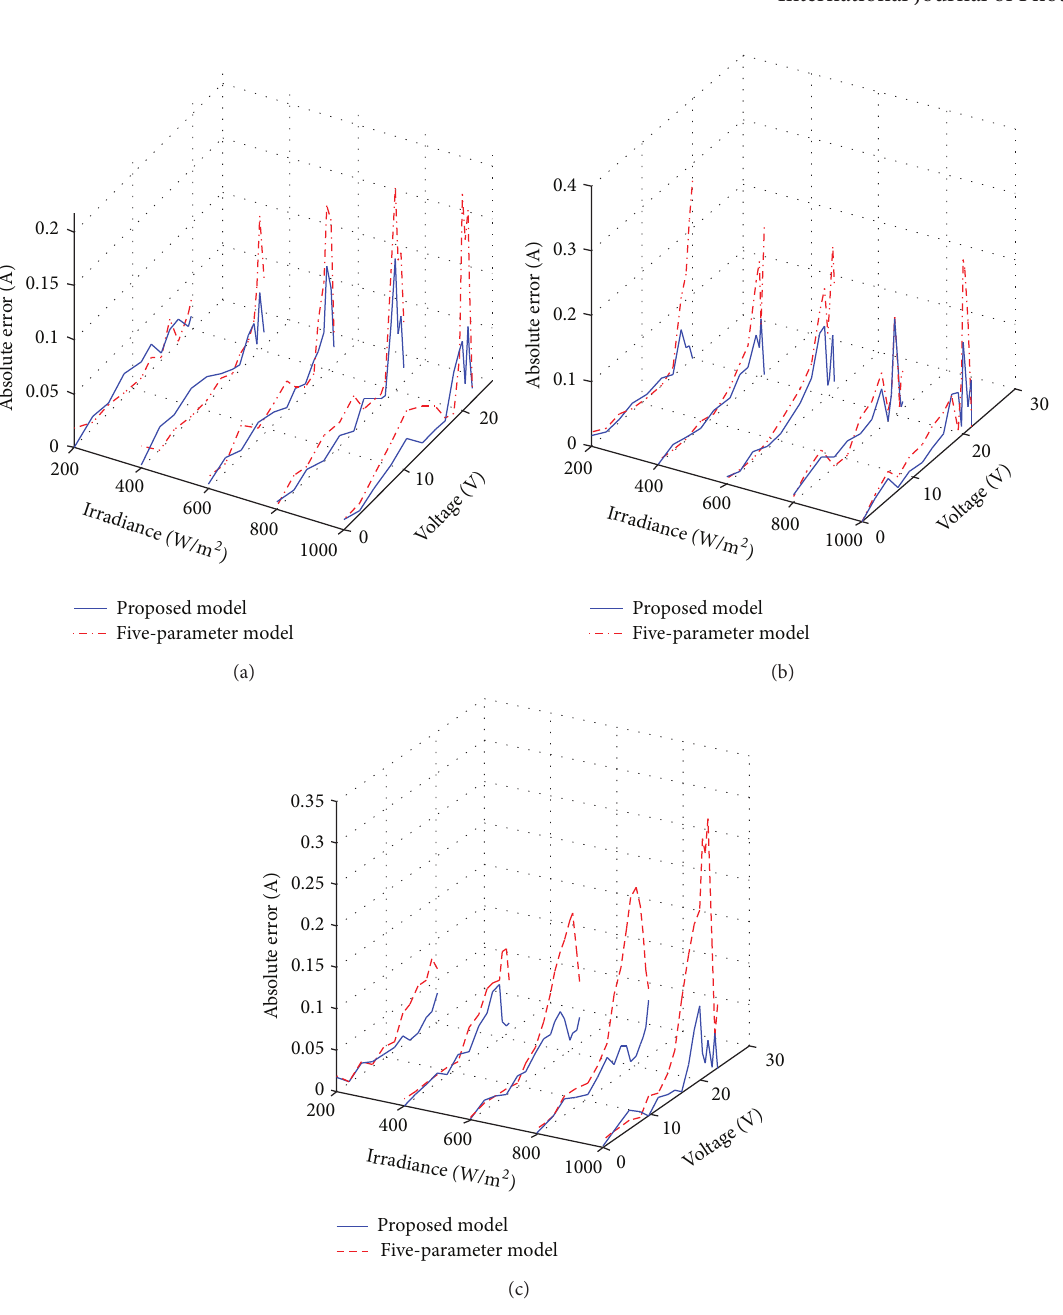
Figure 5: Absolute errors for different irradiance levels of Shell SM55 (a), Shell S75 (b), and Shell ST40